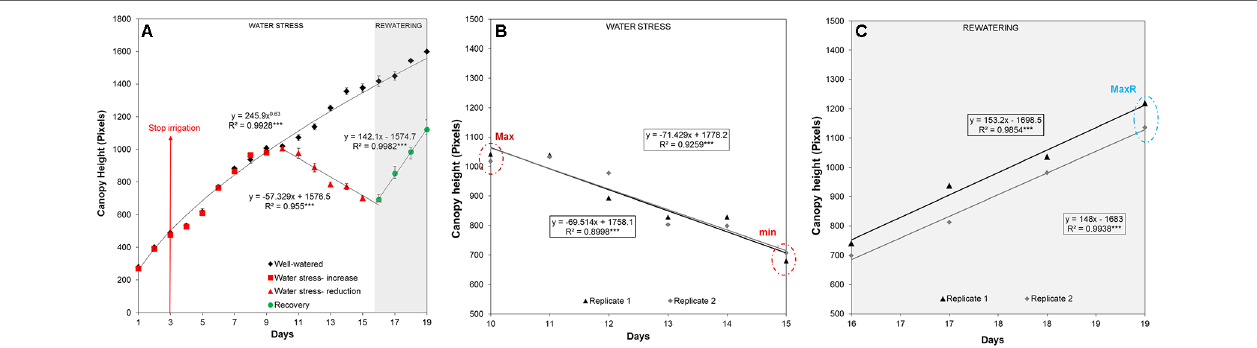
FIGURE 4 | Linear curve of the projected canopy height and the extracted traits. (A) The average canopy height, regression curve and significance calculated from three independent trays (with 50 plants each) growing under water deficit conditions for 13 days (with the endpoint at day 16) and with subsequent rewatering for 4 days (with the endpoint at day 19). (B) Max is the maximum and Min the minimum canopy height reached by the stressed plants from replicate 1 or 2 (n = 50) under water deficit conditions, and the slope of the linear model curve is shown. (C) MaxR is the maximum canopy height from replicate 1 or 2 (n = 50) attained after 4 days of rewatering, and the slope of the line (SlopeR) is also shown in the equation.